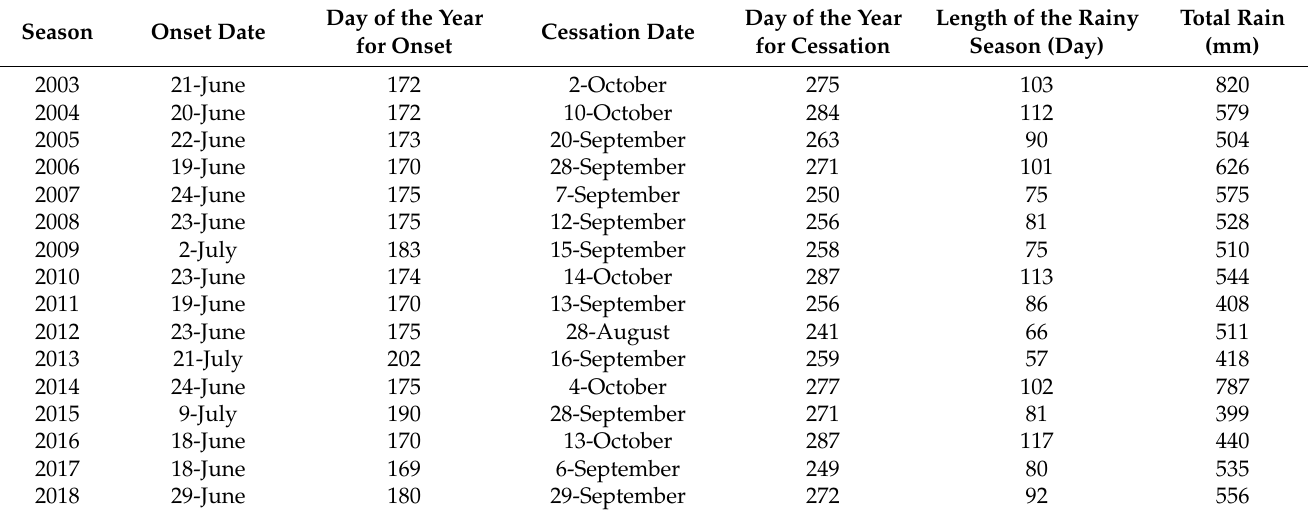
Figure 7. Relationships between the length of the rainy season and yield of five major crops grown in Gedaref state, Sudan. R 2 is coefficient of determination. 3.6. Assessment of the Relationship between Climatic Variables and Crop Yield in Gedaref State The result of the relationships among crop yield and temperature variables as well as rainfall, as assessed using Pearson’s correlation, are presented in Figure 8. There were negative relationships among the temperature-based variables (Tmin, Tmax, and DTR) and crop yield, whereas the relationships among rainfall and crop yield were positive. The associations among all studied climate variables and most of the crop yields were significantly correlated ( p < 0.01), with correlation coefficient values of above 0.5, except for millet and Tmin and rainfall, cotton and all climate variables, and sesame and DTR (Figure 8).